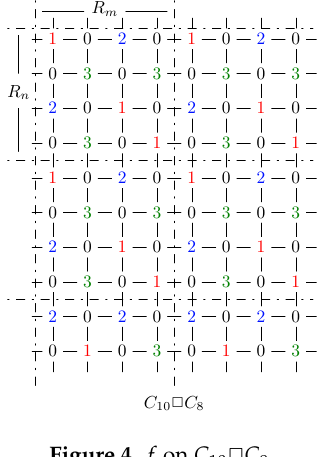
Figure 4. f on C 10 2 C 8